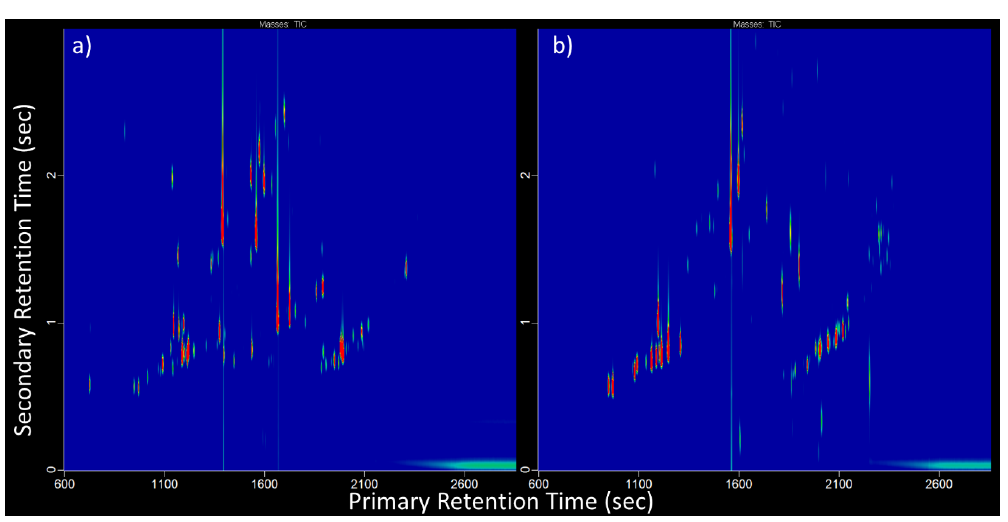
Figure 1. The total ion two-dimensional chromatography time-of-flight mass spectrometry (GC × GC-TOFMS) chromatograms of ( a ) lavender oil; ( b ) tea tree oil. The GC × GC chromatograms show many common terpene components.